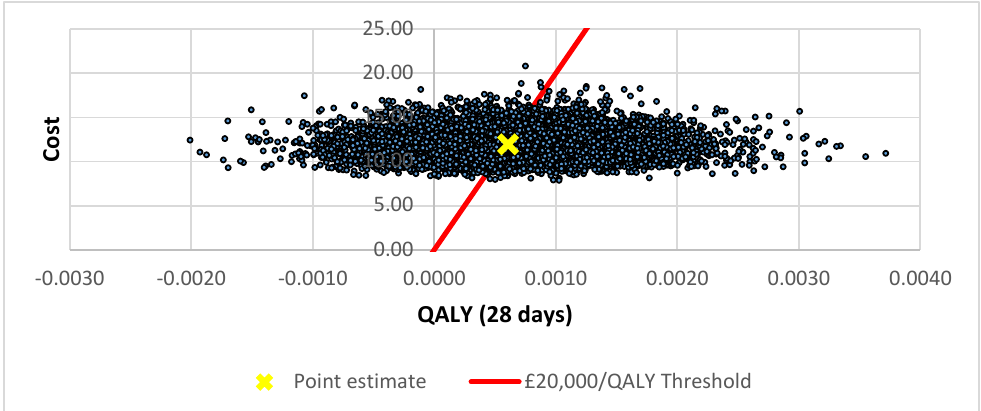
Figure 1. Cost-effectiveness plane for pragmatic use of POC CRP testing.